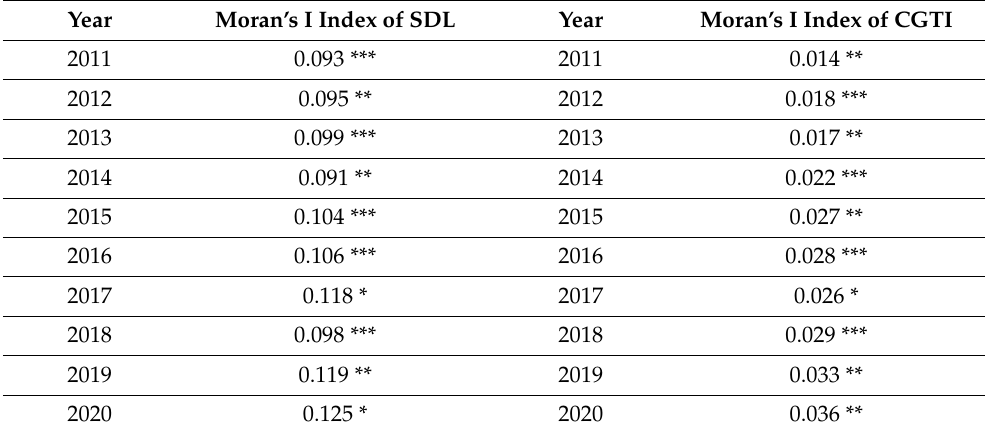
Table 6. Moran’s I index of SDL and